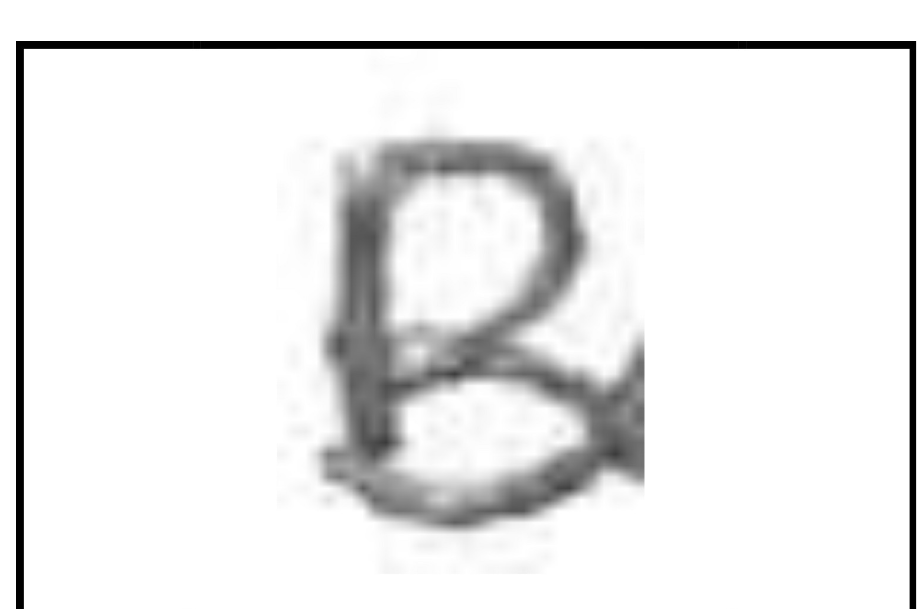
Fig 5. The only handwritten allographic feature from writers from Tamil vernacular